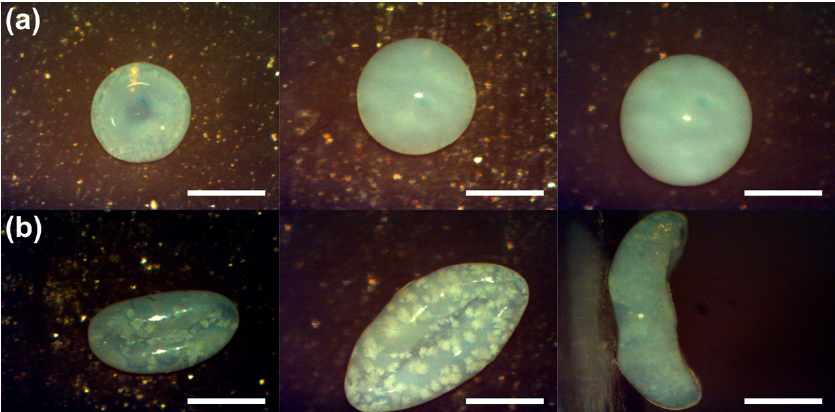
Figure 9. Examples for anisometric supraparticles obtained from drying fumed silica (FS) suspensions (from left to right 1.75%, 3.50%, 5.25% w / v ) for an initial ionic strength of ( a ) 0.001 mM and ( b ) 25 mM using NaCl; the last image on the right side shows a side-view perspective. The scale bars are 500 µm. Adapted with permissions from [93,96] (pp. 587, 598). Copyright 2014 Wiley.